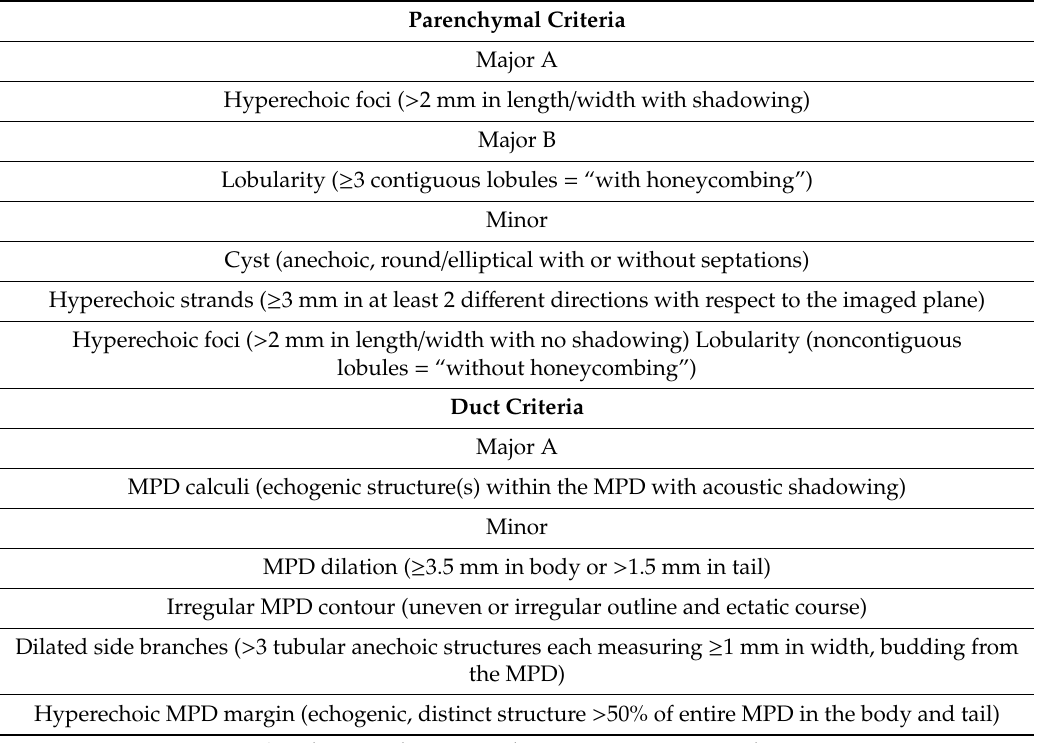
Table 1. The Rosemont